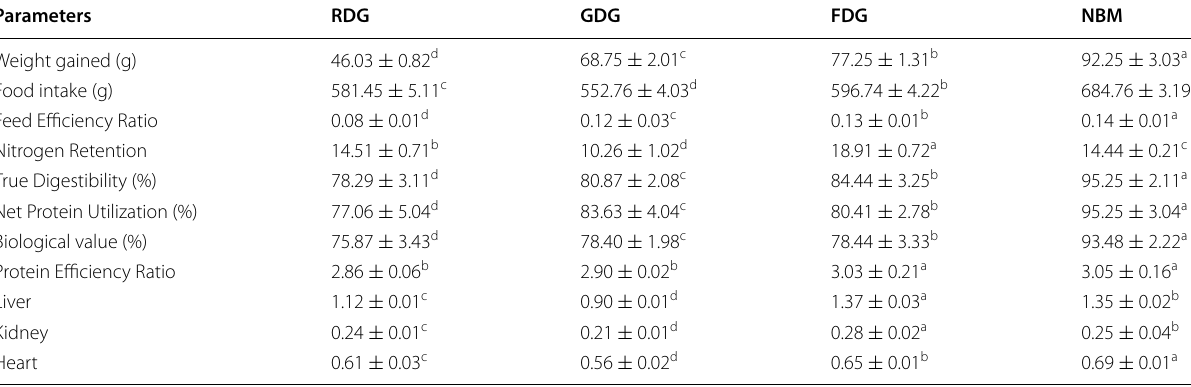
RDG Raw maize, defatted groundnut and ginger in ratio 76.7:20.8:2.5 GDG Germinated maize, defatted groundnut and ginger in ratio 74.4:23.1:2.5 FDG Fermented maize, defatted groundnut and ginger in ratio 72.6:24.9:2.5 NBM Nutribom (a commercial maize-based complementary food) a, b, c, d Means ( SEM) with different alphabetical superscripts in the same row are significantly different at P < ±